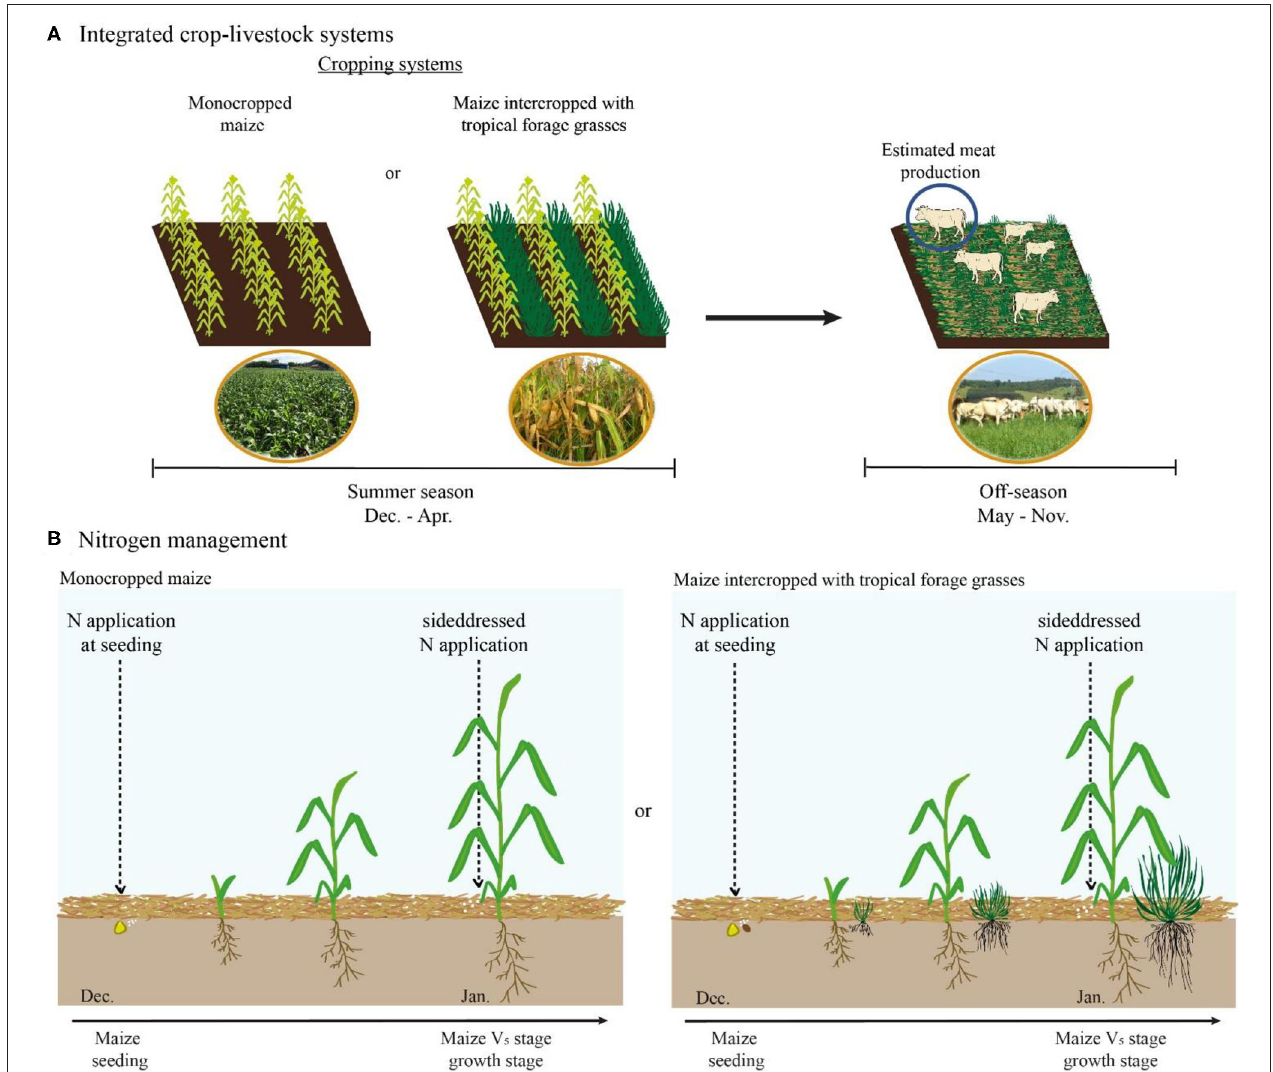
FIGURE 2 | (A) Scheme of cropping systems arrange in the summer season. Grazing by animals was not performed after maize harvest in off season and meat production was estimated using Large Ruminant Nutrition System model. (B) Timing of N application (seeding + sidedressing) in the monocrop and intercrop system in the summer